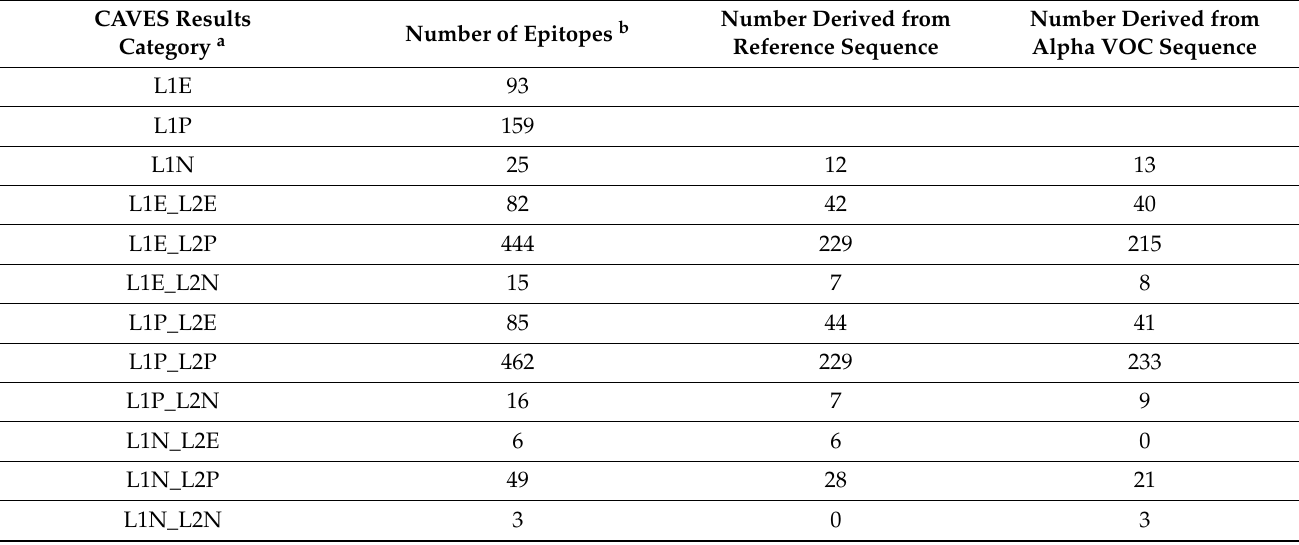
Table 1. Number of epitopes in each category as determined by CAVES